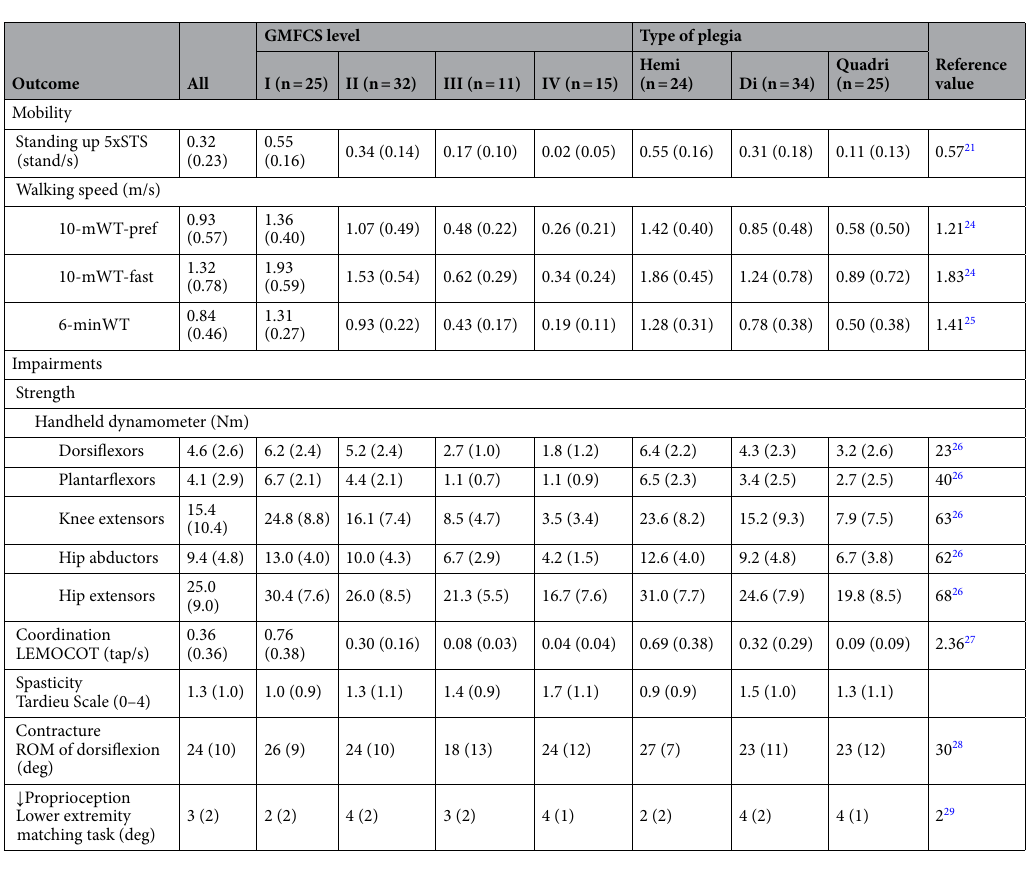
Table 2. Mean (SD) of outcomes for all participants, each level of GMFCS and each type of cerebral palsy. SD Standard Deviation, GMFCS Gross Motor Function Classification System, 10-mWT 10-m Walk Test, 6-minWT 6-min Walk Test, 5xSTS 5 times sit to stand, OLST One-Legged Stance Test, LEMOCOT Lower Extremity Motor Coordination